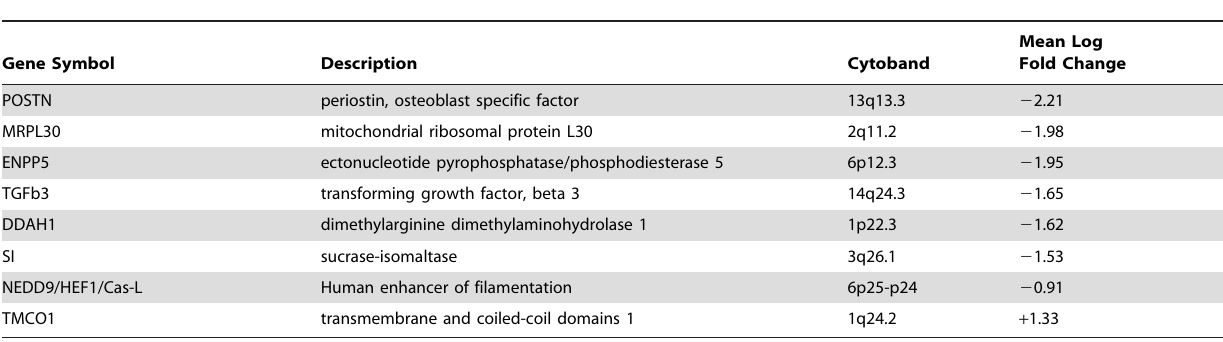
Table 1. Differentially expressed genes in all 14